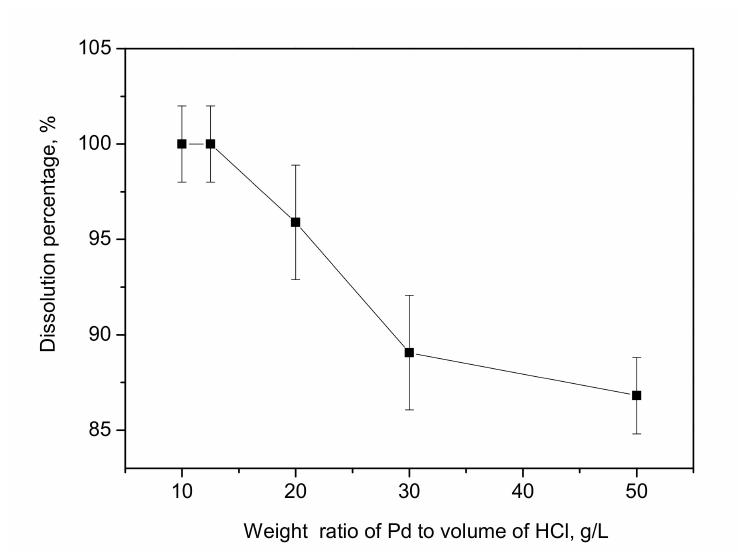
Figure 5. Effect of the weight ratio of Pd to concentrated HCl on the dissolution of Pd. Conditions: TBP = 3 M; diluent: kerosene; Pd/H 2 O 2 ratio = 10 g/L; 60 ◦ C, 60